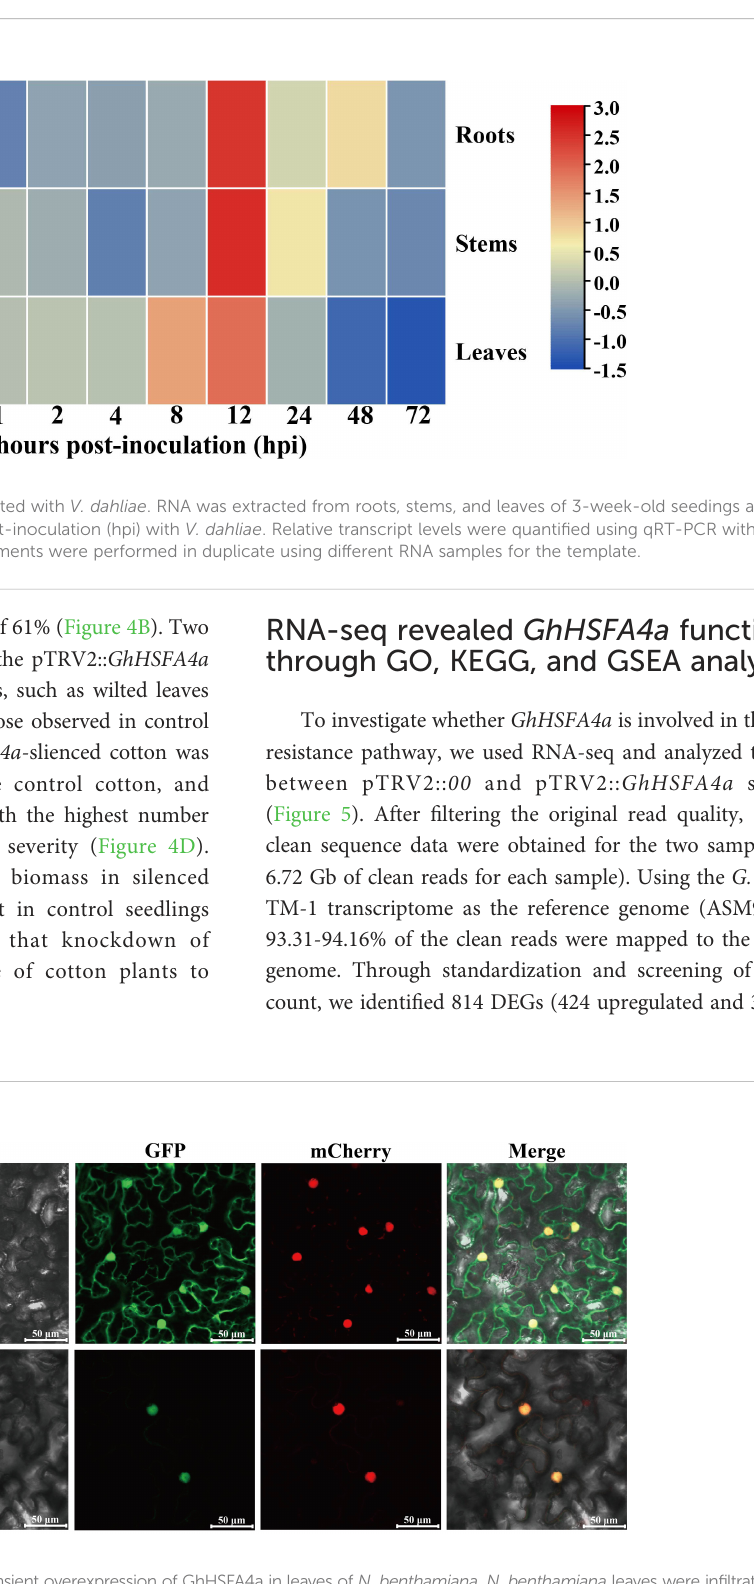
FIGURE 3 GhHSFA4a was localized in nucleus after transient overexpression of GhHSFA4a in leaves of N. benthamiana . N. benthamiana leaves were in fi ltrated with EHA105 cells containing pYBA1132::GhHSFA4a::GFP and using pYBA1132::GFP as a control. Shown are the confocal micrographs